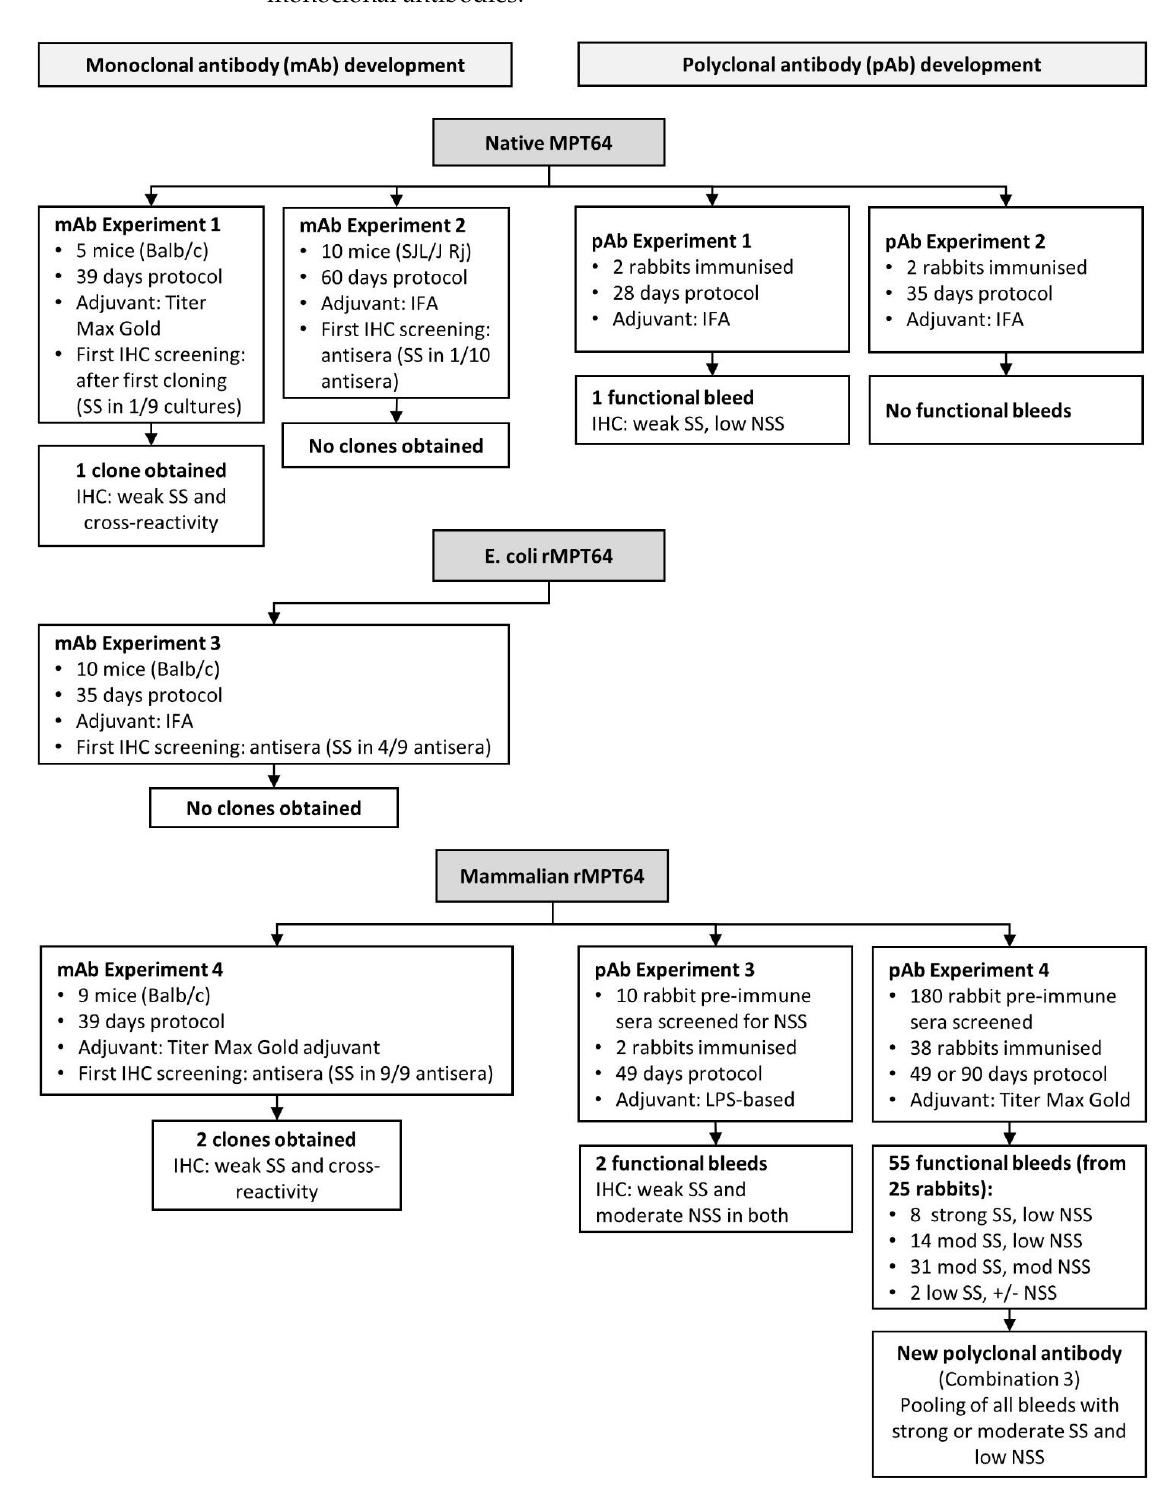
Figure 1. Overview of the different strategies used to develop monoclonal and polyclonal anti-MPT64 antibodies. Abbre- viations; IFA, incomplete Freund adjuvant, IHC, immunohistochemistry; mod, moderate; NSS, non-specific staining; SS, specific staining; rMPT64, recombinant MPT64.